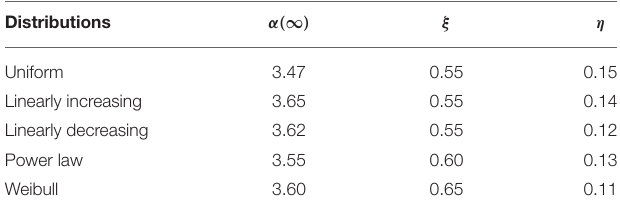
TABLE 1 | The table shows the exponents α ( ∞ ) (Equation 16), η (Equation 15), and ξ (Equations 14, 15) related to the system size scaling of the energy size